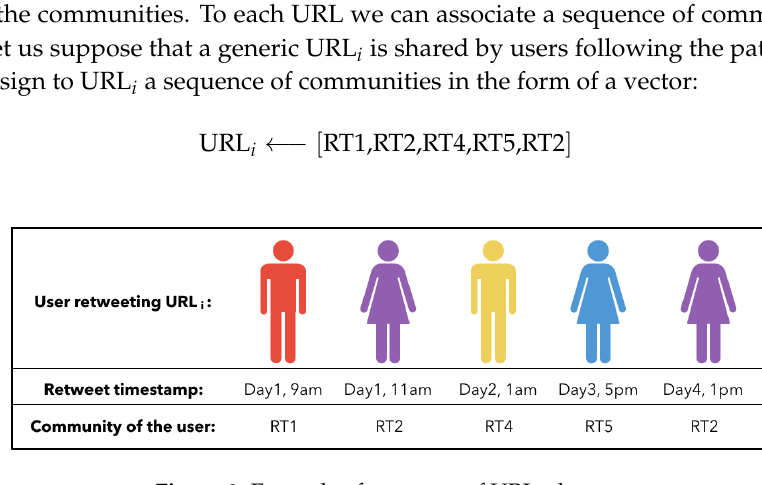
Figure 9. Example of sequence of URL i